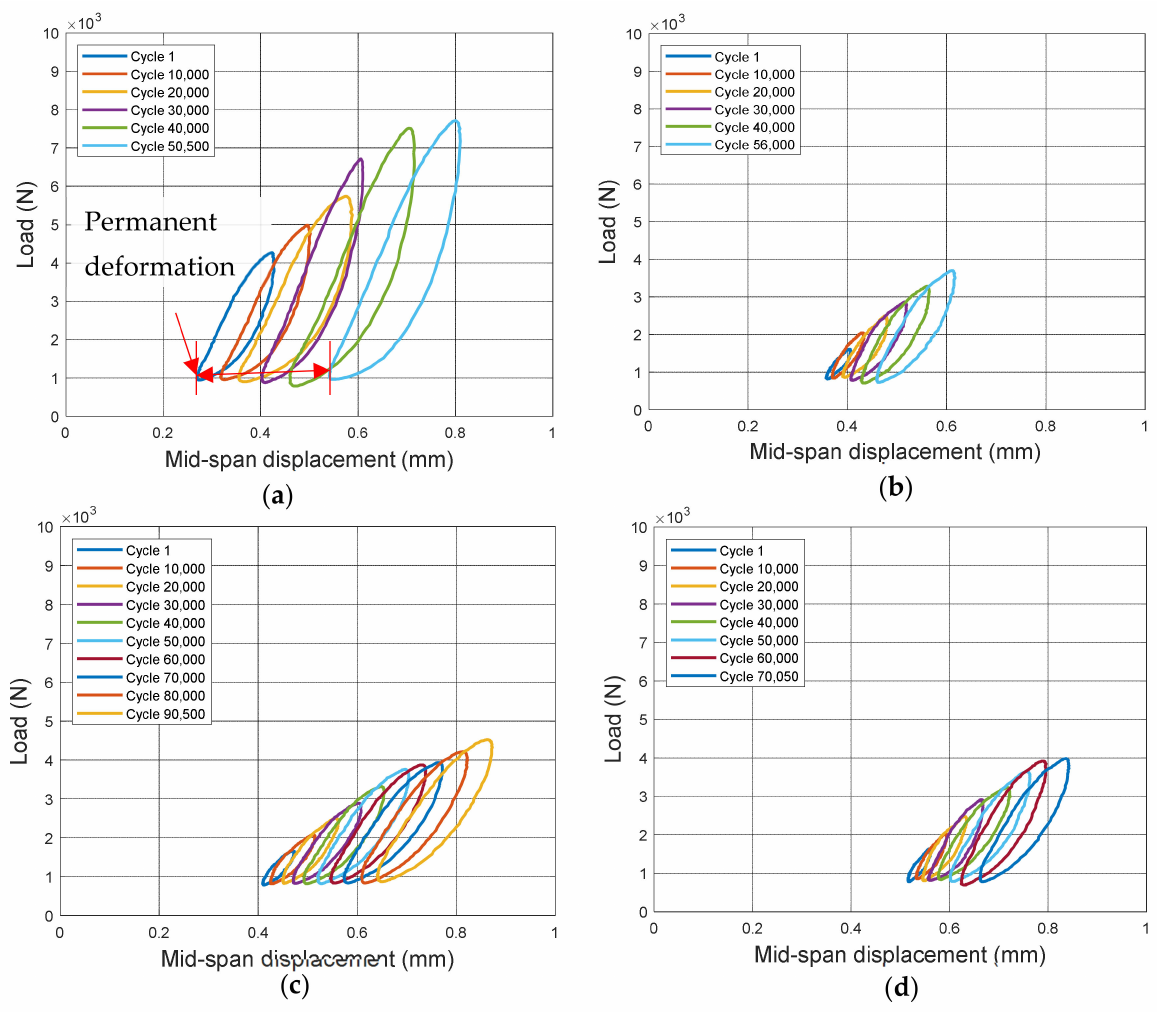
Figure 9. Hysteretic force-displacement curves of representative specimens for ( a ) Mix S ( b ) Mix F ( c ) Mix M ( d ) Mix